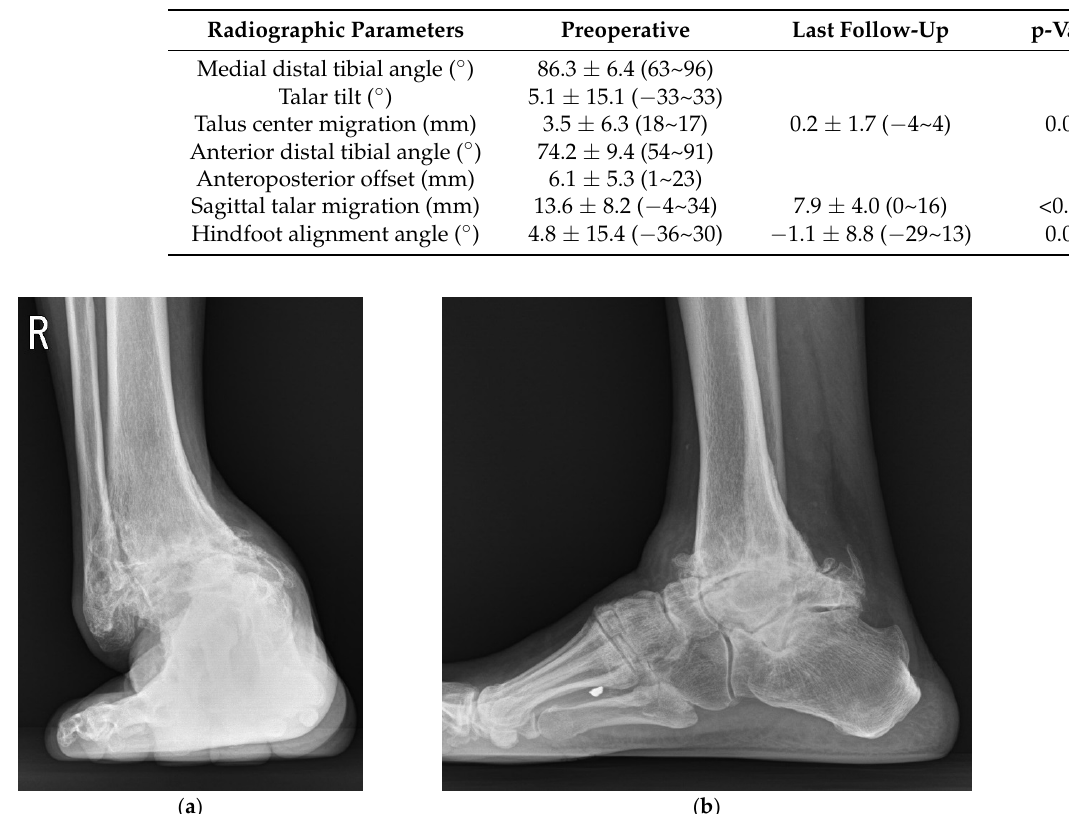
Figure 10. Preoperative weightbearing radiographs showed end-stage ankle arthritis with severe varus deformity: ( a ) anteroposterior view; ( b ) lateral view.